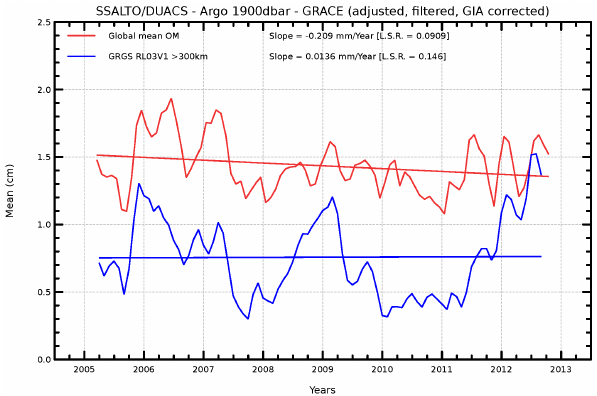
Figure 7. Differences between SSALTO/DUACS 2014 global MSL and the sum of the Argo steric sea level (referenced to 1900dbar) and the GRACE ocean mass contribution derived from the global mean contribution (Johnson and Chambers, 2013 in red) and the GRGS RL03v1 data set (Biancale et al., 2014, in blue). The GRGS grids have been averaged over the ocean with a mask over the 300km coastal band and corrected for GIA effect using the mean over the same area of the Geruo et al. (2013) model. Annual and semi-annual signals have been adjusted and an arbitrary vertical off- set has been applied to the curves for